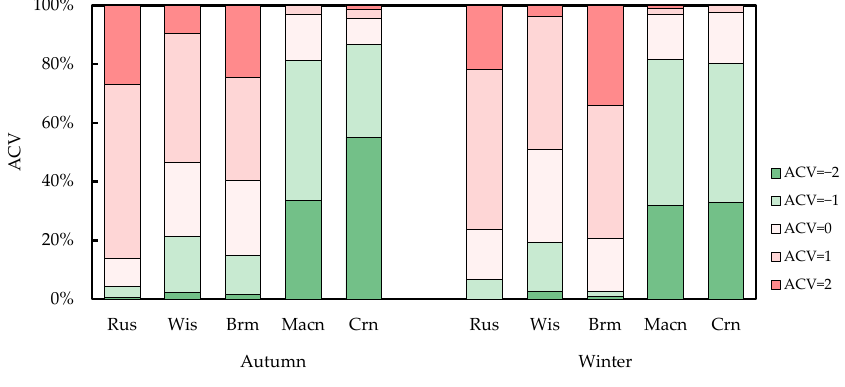
Figure 4. Distribution of the ACVs among sound